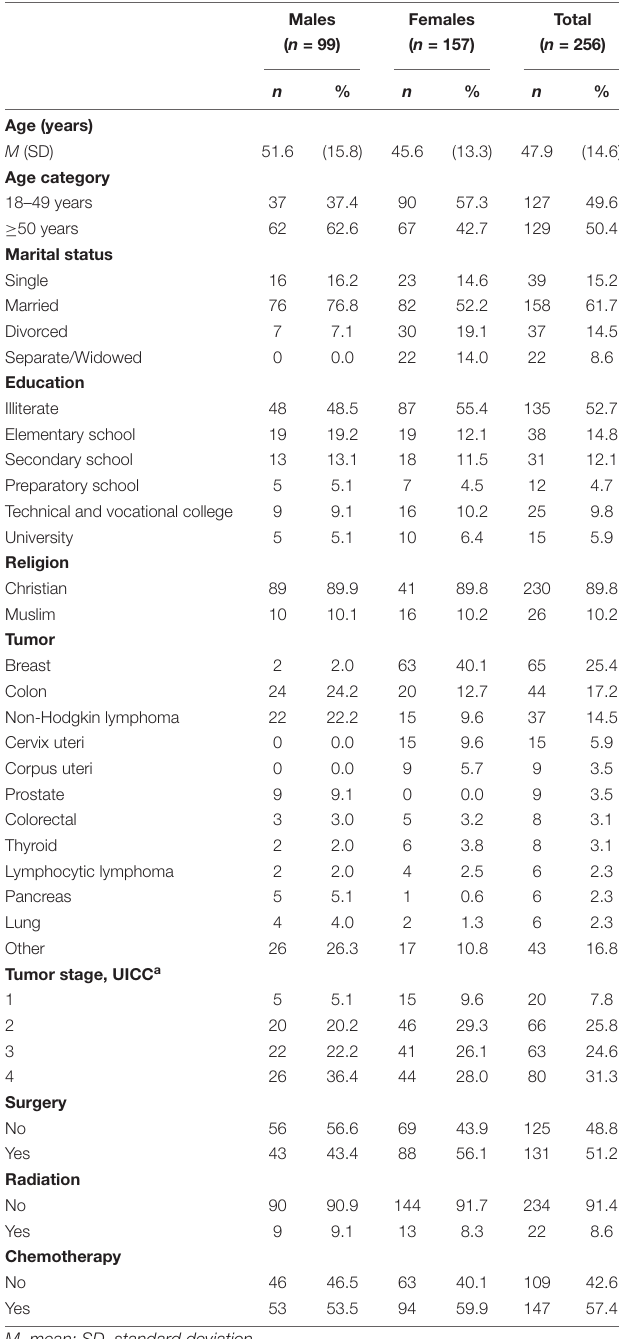
M, mean; SD, standard deviation. a Missing data not reported.